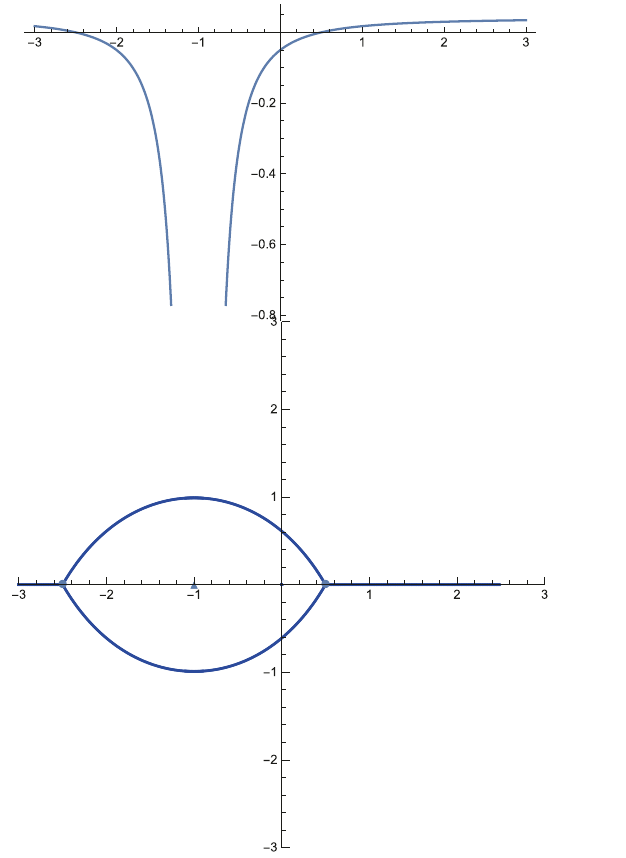
Figure 2 . The upper panel is the “potential” of Q ( x R ) = − E 2 − m 2 (1+ ax R ) 2 0 . 2 plotted for real x R (horizontal axis), and the lower panel shows the Stokes lines on the complex